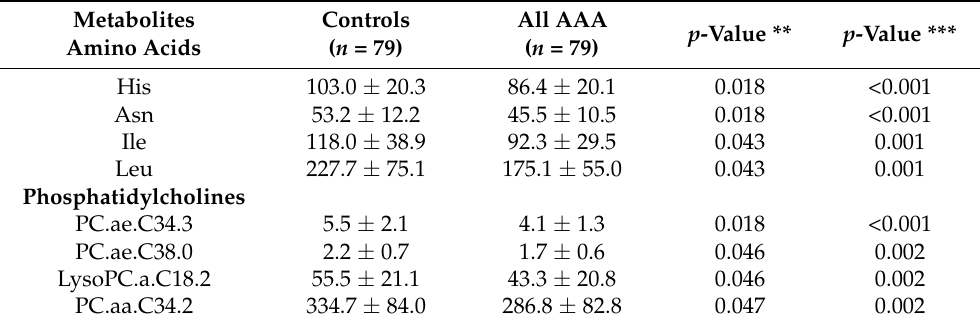
Table 2. Low-molecular weight metabolites in plasma from infra-renal AAA patients and controls *.